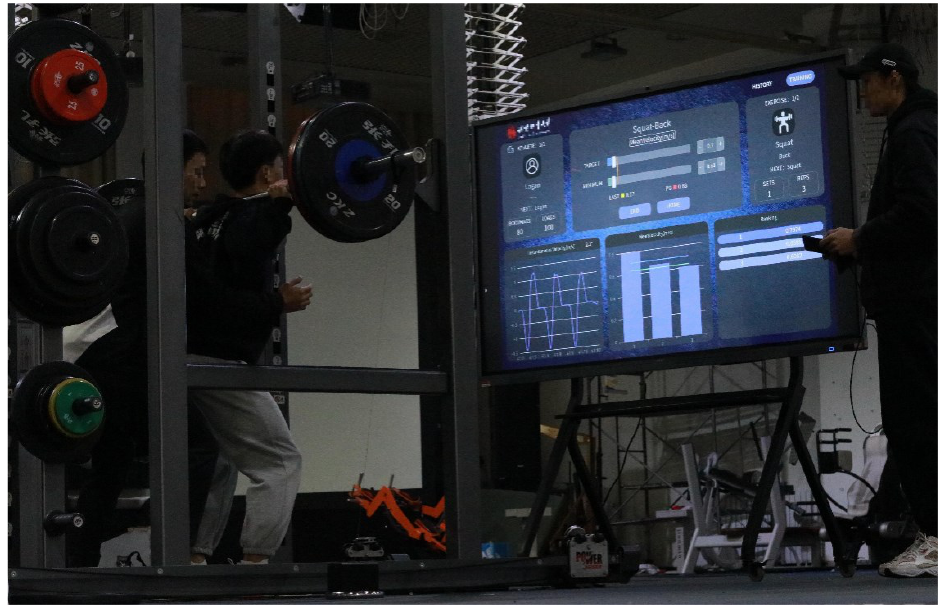
Figure 10. The FRTMS being used in squat training.